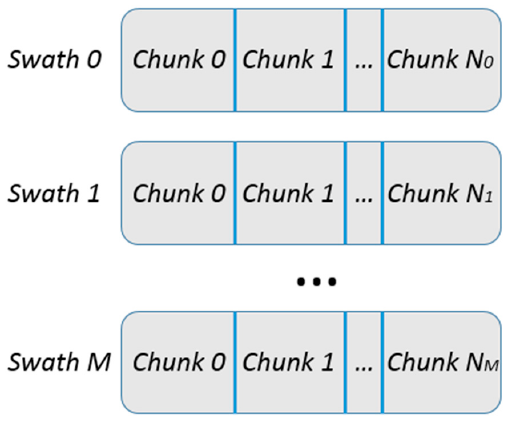
Figure 8. Graphic representation of the Level 1a data structure for ABI.